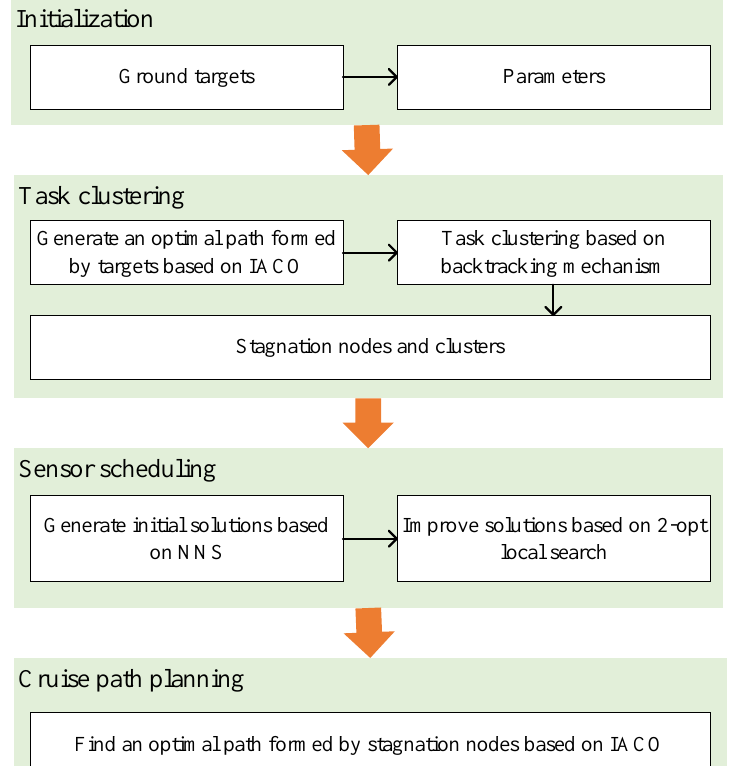
Figure 2. The framework of the proposed observation scheduling